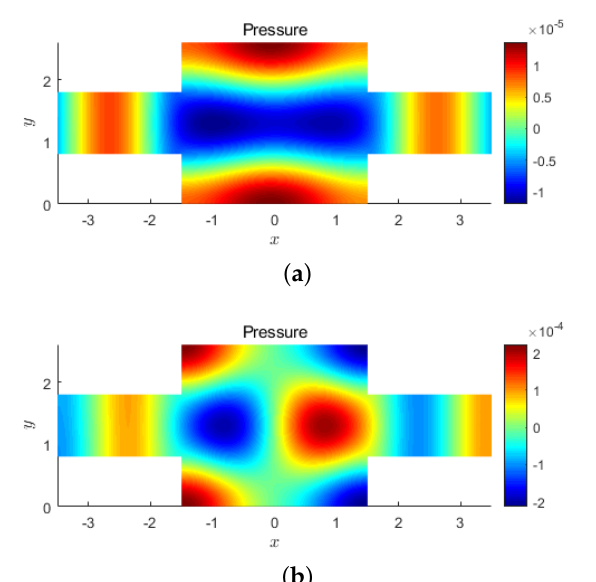
Figure 2. Resonances for the Neumann problem: ( a ) first trapped mode: f = 0.394; ( b ) second trapped mode: f =